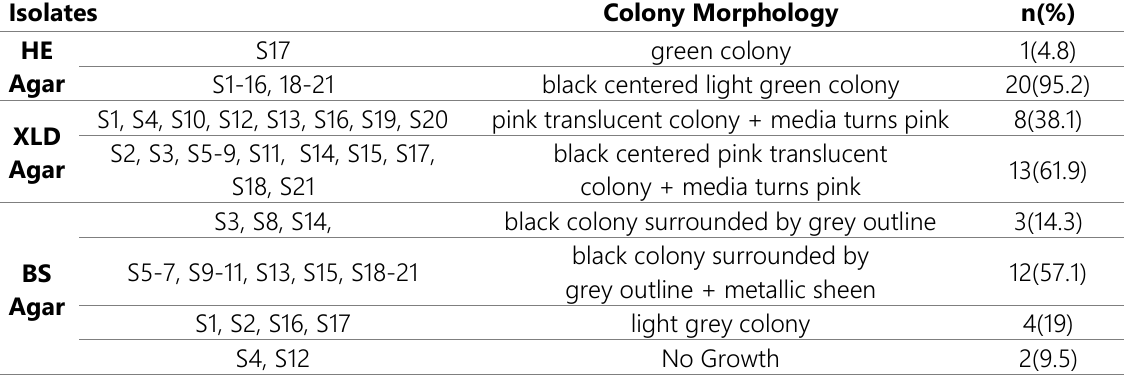
Table 2: Colony morphology of Salmonella on different Selective media Isolates Colony